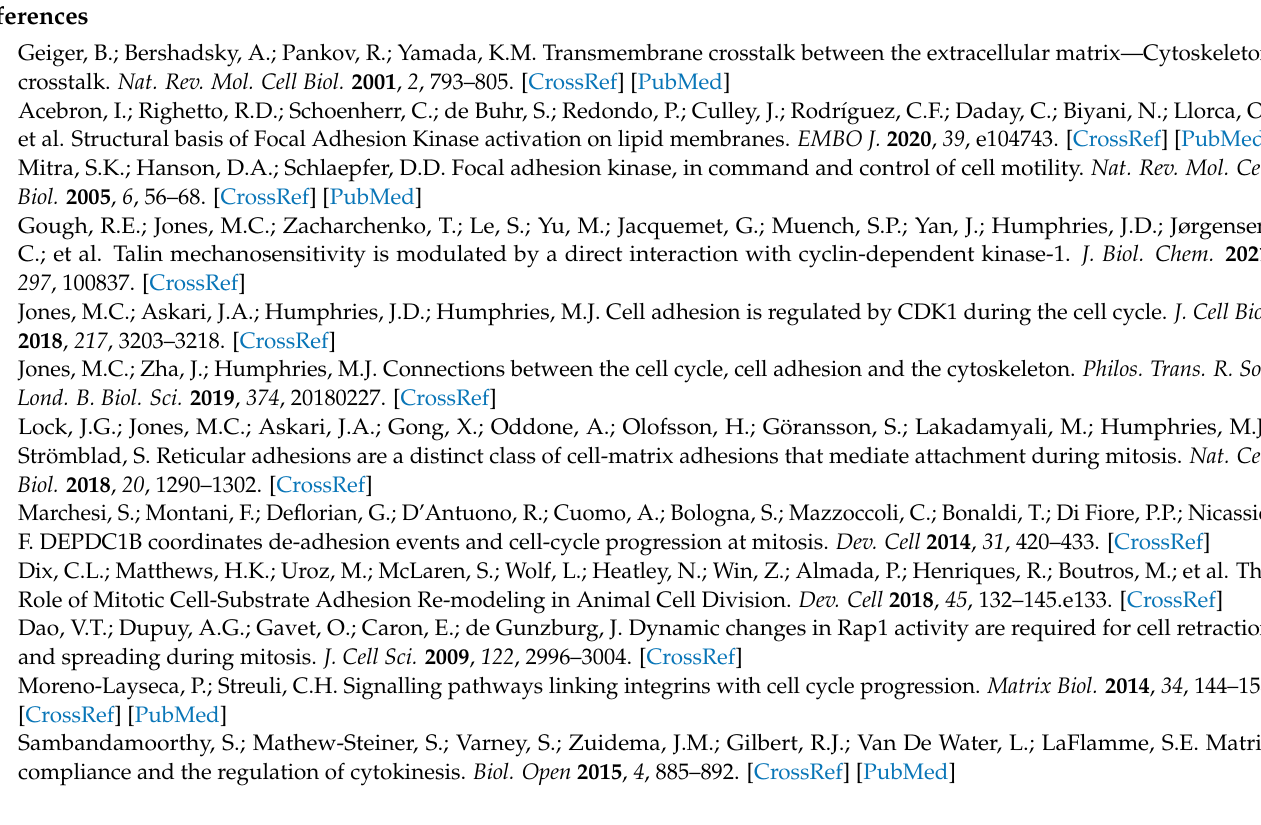
Figure S6: The separation of centrosomes in the Tet-FAK-ON and -OFF cells, Movie S1A,B: The cell cycle progression of BJ fibroblasts during G2 and M phases, Movie S2A,B: The lack of adhesion causes mitotic progression delay, Movie S3A,B: FAK inhibition prolongs the G2 phase, Movie S4: Induction of mitotic cell death after switching off